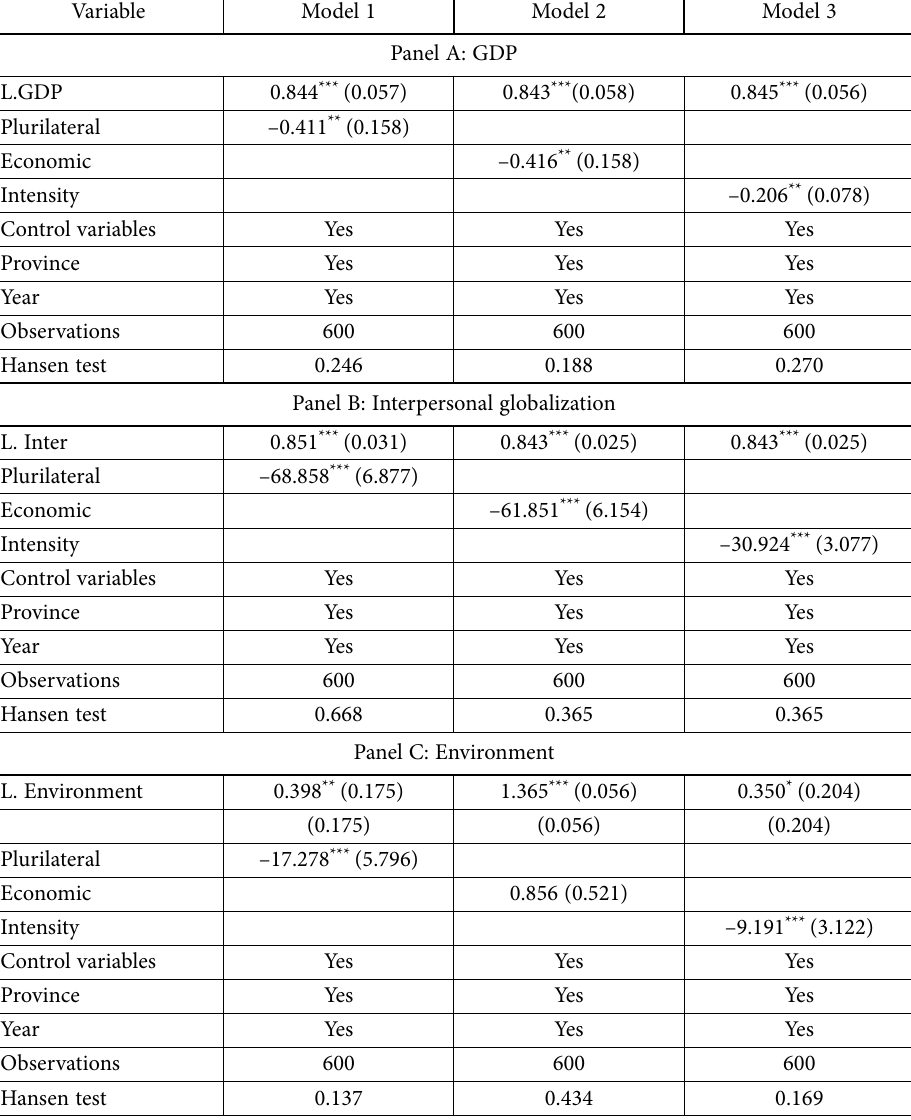
Table 6. Estimation results of the influencing